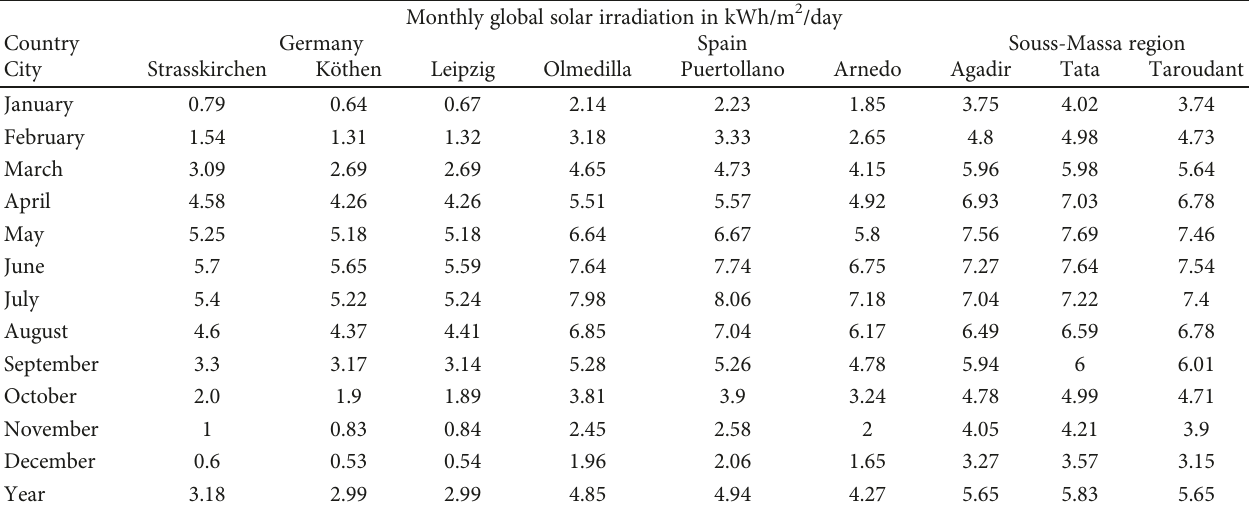
Table 5: The monthly global solar irradiation comparison between the studied area and other European sites located in Germany and Spain.